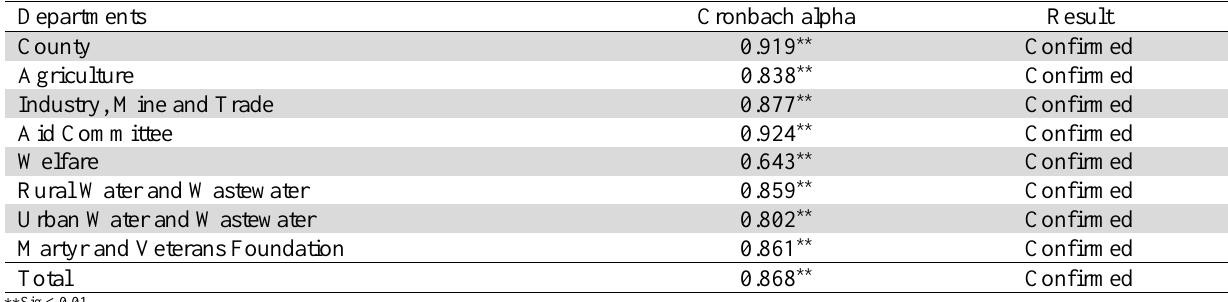
Correlation test between organizational culture and organizational success in all departments of Khorasan